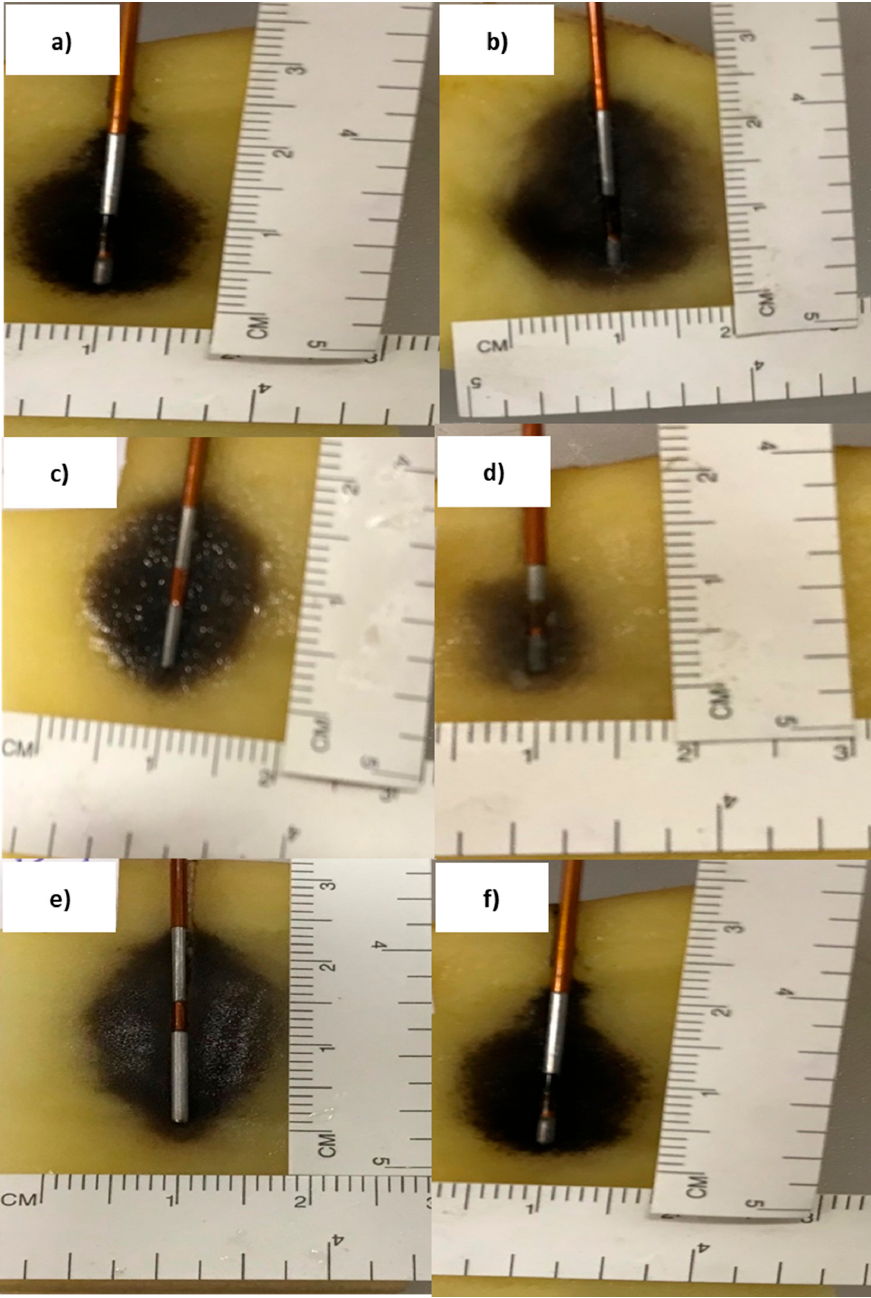
Figure 5. Examples of tests conducted on potatoes of Table 2. The black zone identifies the electroporated area 24 h after the treatment, while the surrounding area is vegetable material that is not electroporated. ( a ) Test 13 (asymmetric geometry) = P1: 3.00 mm, S: 5.00 mm, P2: 10.00 mm,